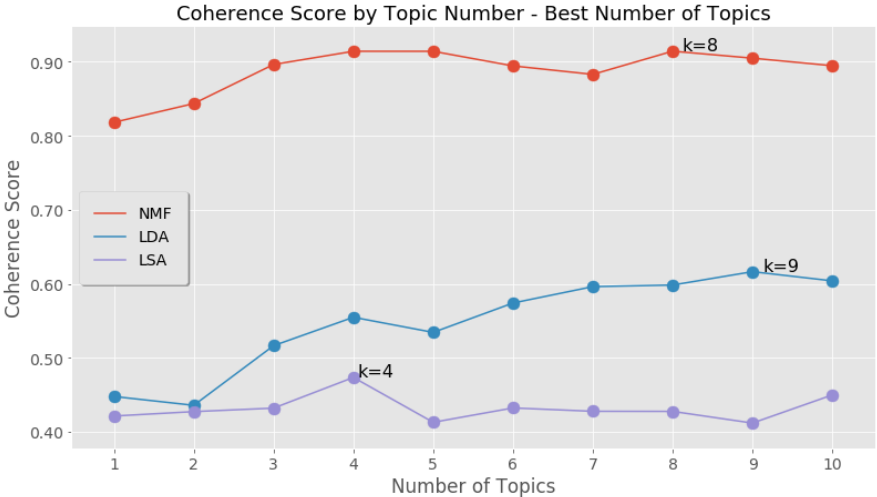
Figure 4. Comparing the techniques (LSA, NMF and LDA)—highest coherence